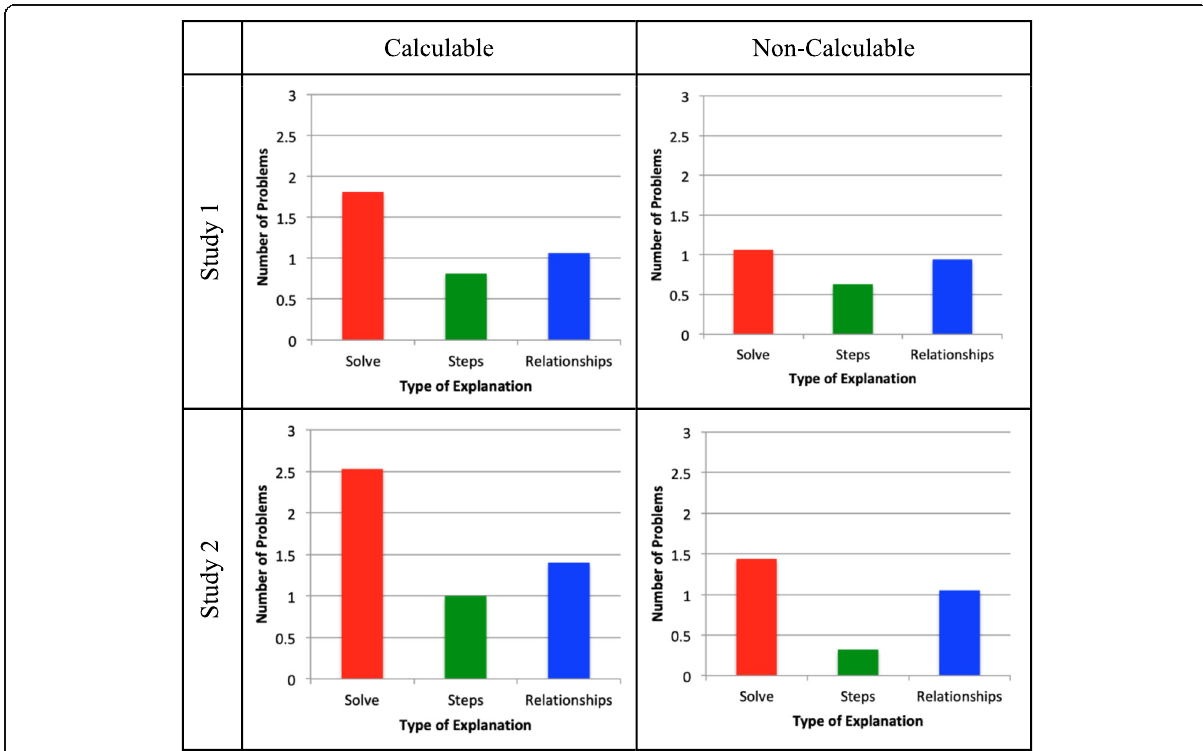
Fig. 2 Number of problems students “ explained ” in different ways, across studies and